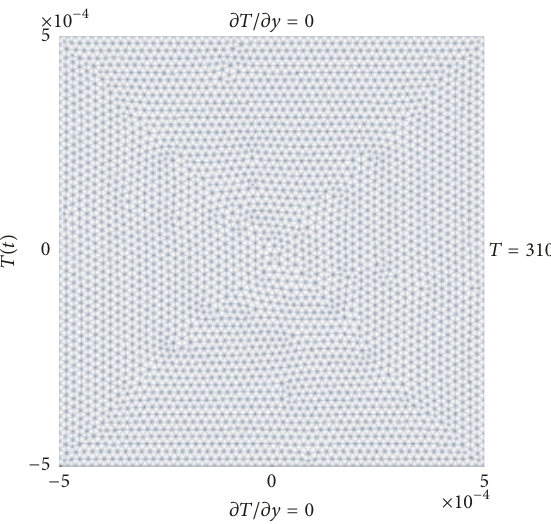
Figure 6: Case 2 mesh and boundary